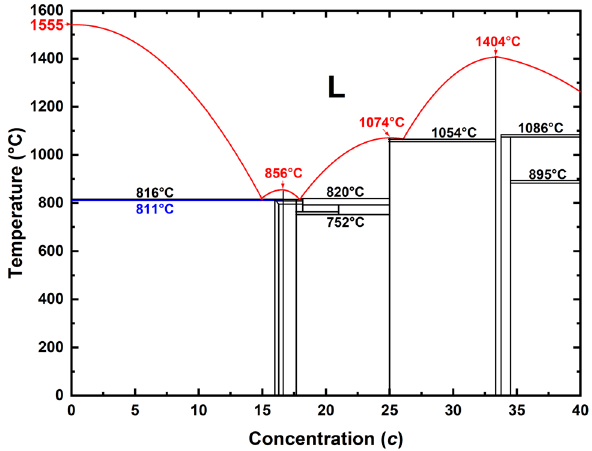
Figure 1. Region of the Pd-Si phase diagram near the eutectic point. The atomic concentrations deployed are 0 ≤ c ≤ 40 at.%. This figure is a linear (black lines) and parabolic (red lines) fit to the experimental values contained in References 13–15